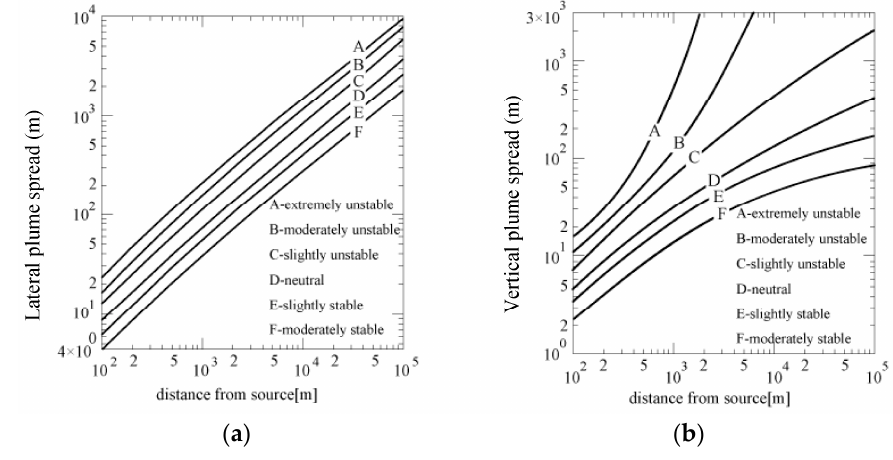
Figure 3. An example determination of effective source height (He’) [4].